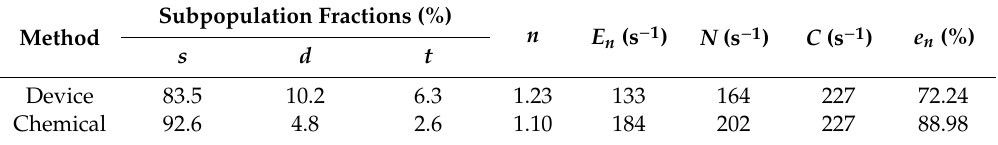
Table 1. Nuclei isolation e ffi ciency and the associated set of values derived for Figure 5.